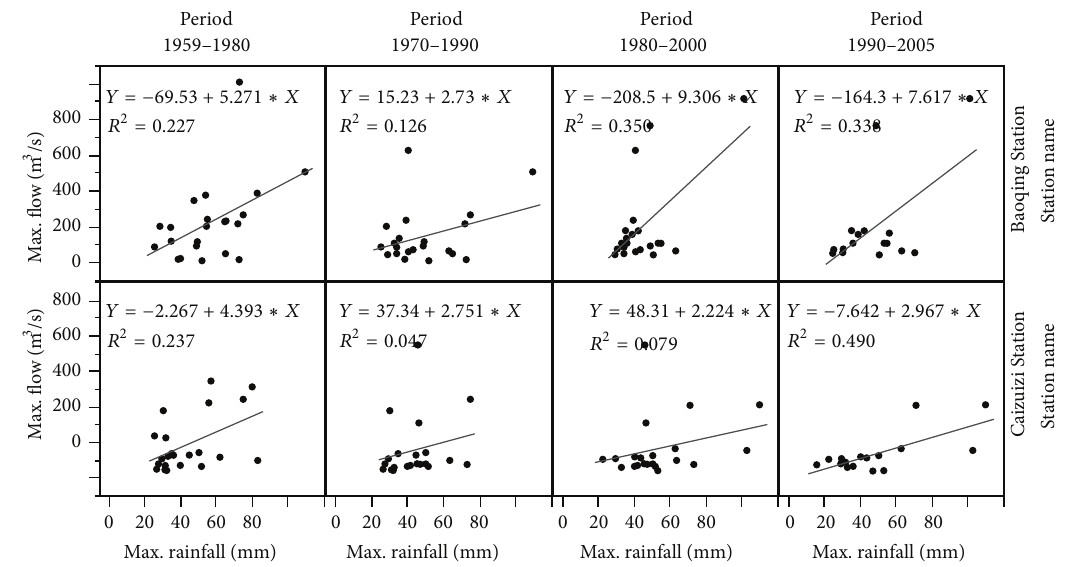
Figure 8: The relationships between maximum flow and maximum rainfall in different